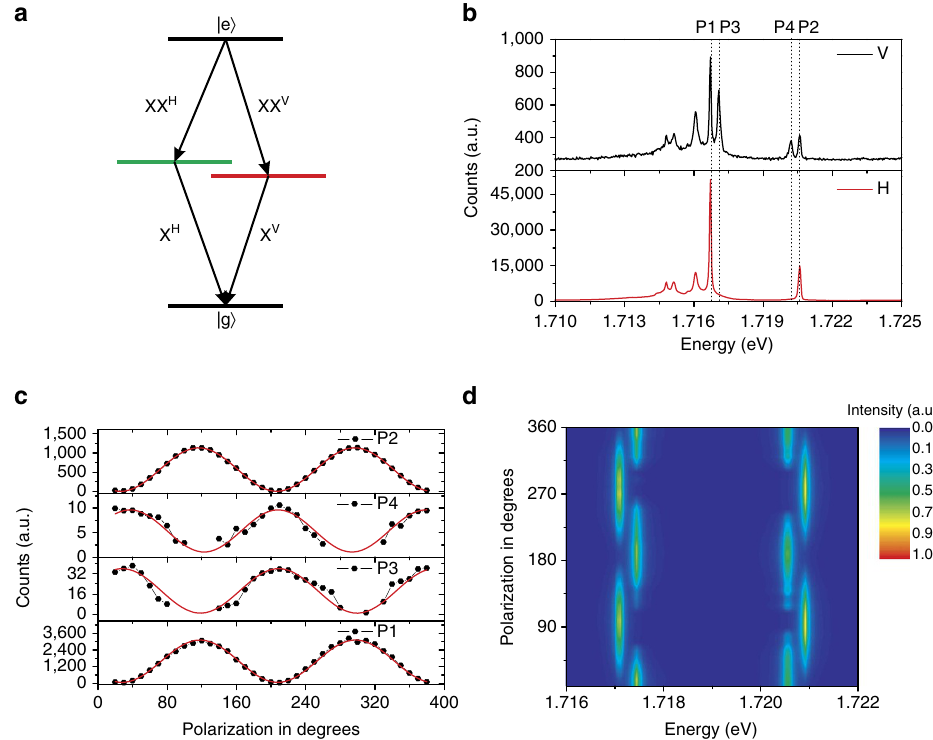
Figure 2 | Polarization-resolved photoluminescence. ( a ) Schematic representation of biexcitonic emission cascade. The fine-structure splitting is expected for the electron-hole exchange interaction in the presence of in-plane anisotropy. ( b ) Polarization-resolved spectrum at linear polarization H, V. Two pairs of spectral doublets are observed at 1.7167 (P1)–1.7171eV (P3) and 1.7202 (P4)–1.7206eV (P2). Four peaks are indicated by the dashed lines. ( c ) The integrated counts of the photon emission from P1, P2, P3, P4 as a function of the polarization detection angle. The red lines are the sinusoidal fits, showing two pairs of cross-linear-polarized doublets. ( d ) Contour representation of the four peaks, after normalizing to the maximum peak intensity, yielding a fine structure splitting B